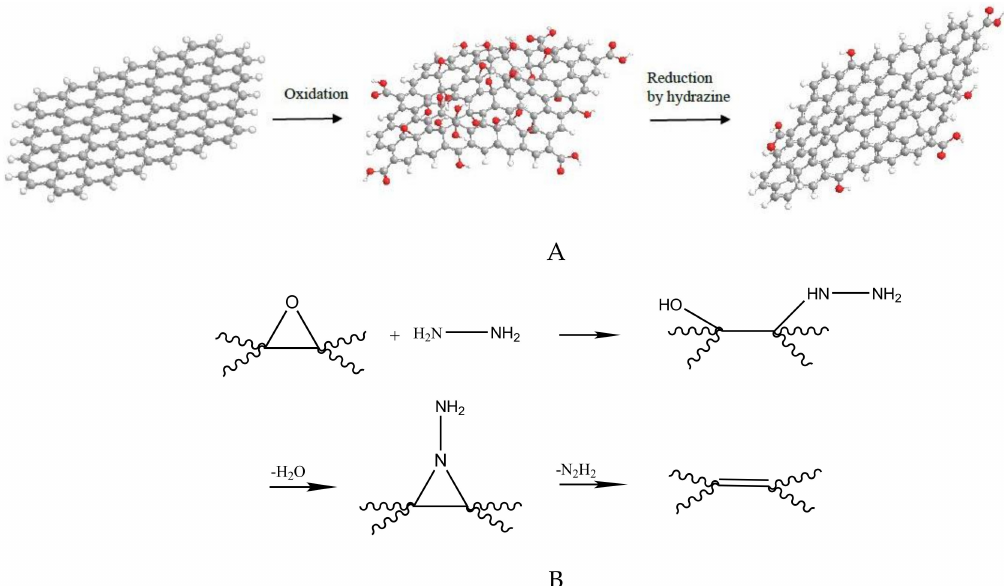
Figure 1. Sketch of the experimental process followed for oxidation ( A ) and posterior epoxy reduction (using hydrazine) ( B ) of graphene nanosheets [the process is described in detail in